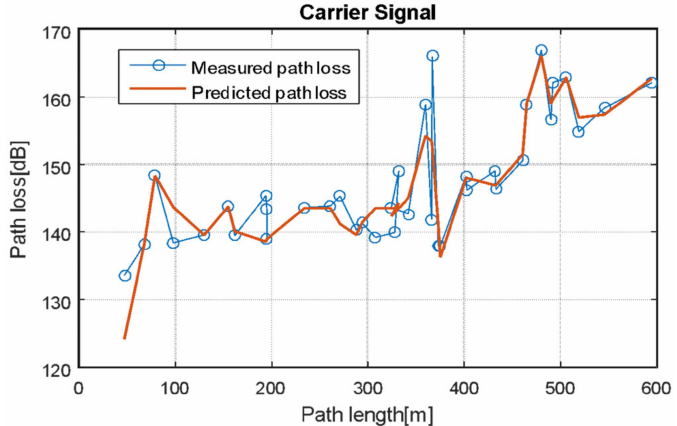
Figure 10. Comparison between measured loss and the prediction ANN model in site 2.